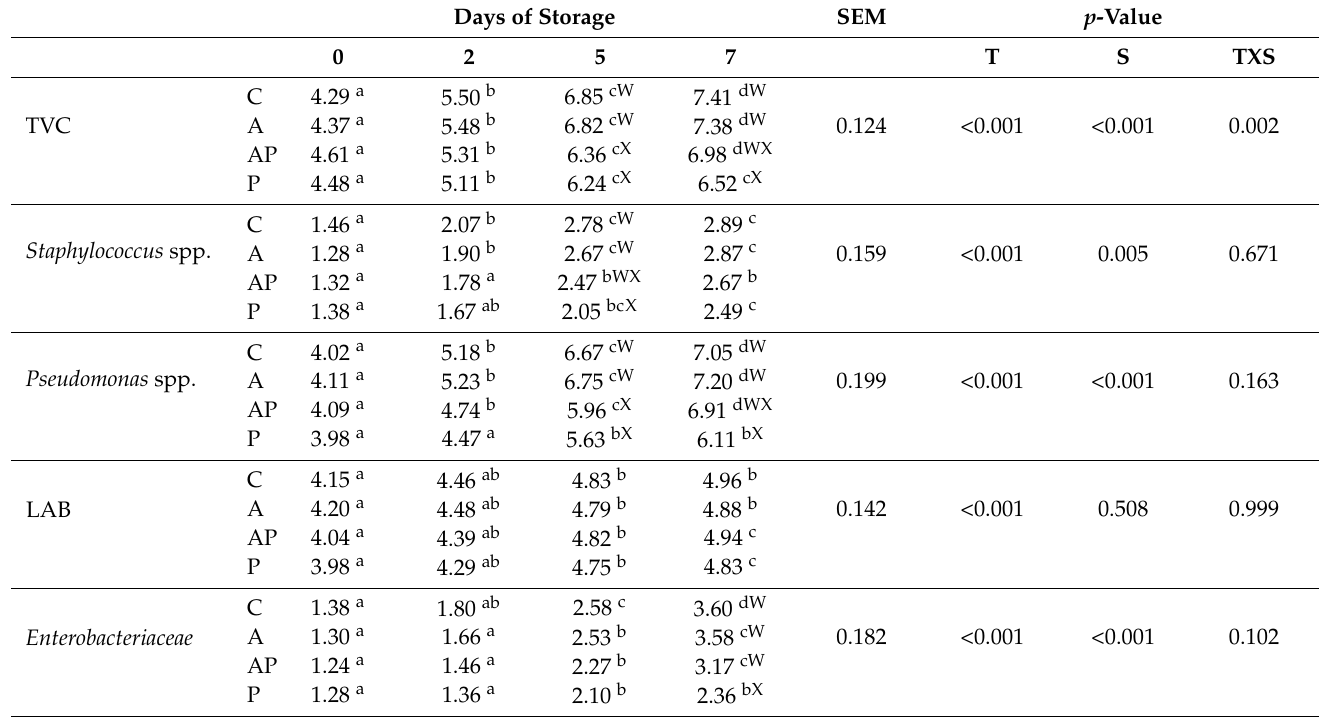
Table 3. Microbial quality (Log CFU/g) of the four formulations of beef burger stored at 4 ◦ C under aerobic conditions for 7